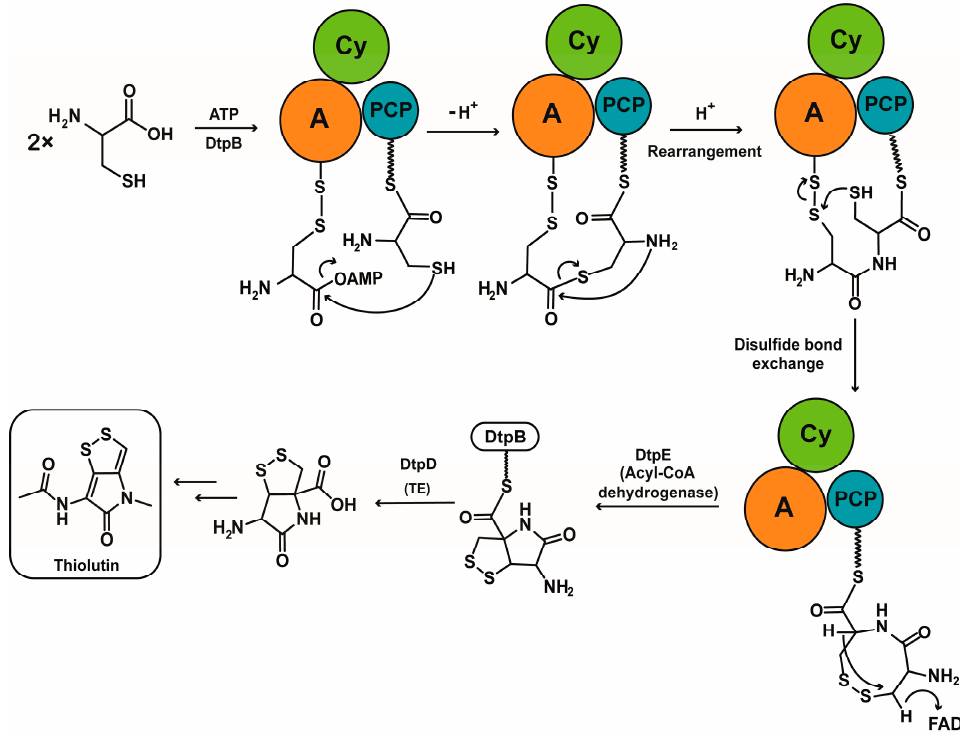
Figure 6. Proposed mechanism for the biosynthesis of bicyclic pyrrolinodithiole sca ff old of thiolutin.